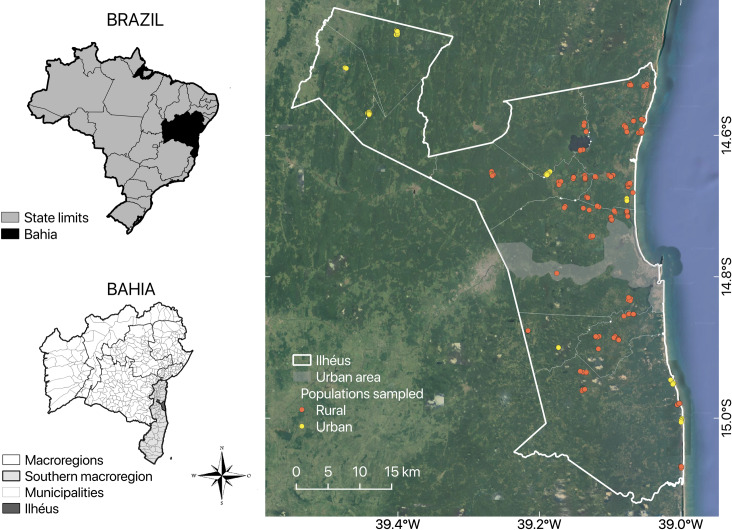
Location of Ilhéus Municipality in Bahia State, Brazil.This map was prepared using QGIS program (version 2.18).